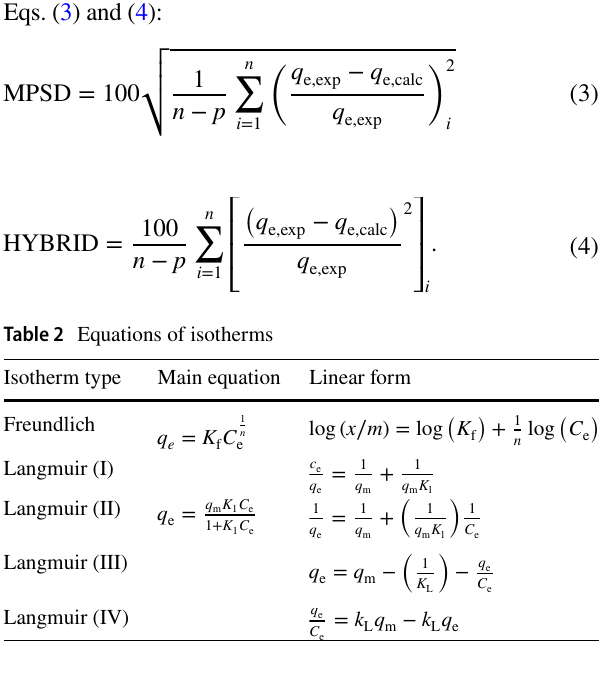
Table 3 Isotherm model constants for the adsorption of PC-G ( C 0 = 50 mg/L and Tem = 298 K)